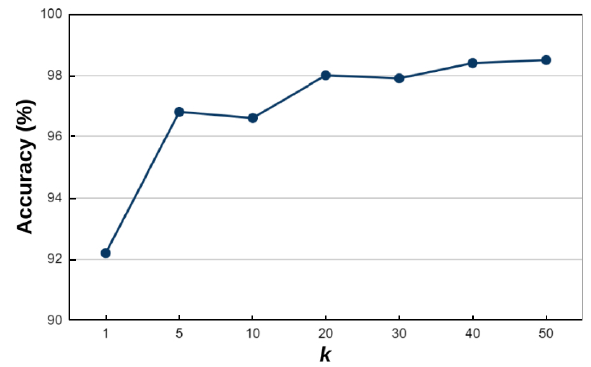
Fig. 6 Accuracy of Method 3 as a function of k ( k -medoids).